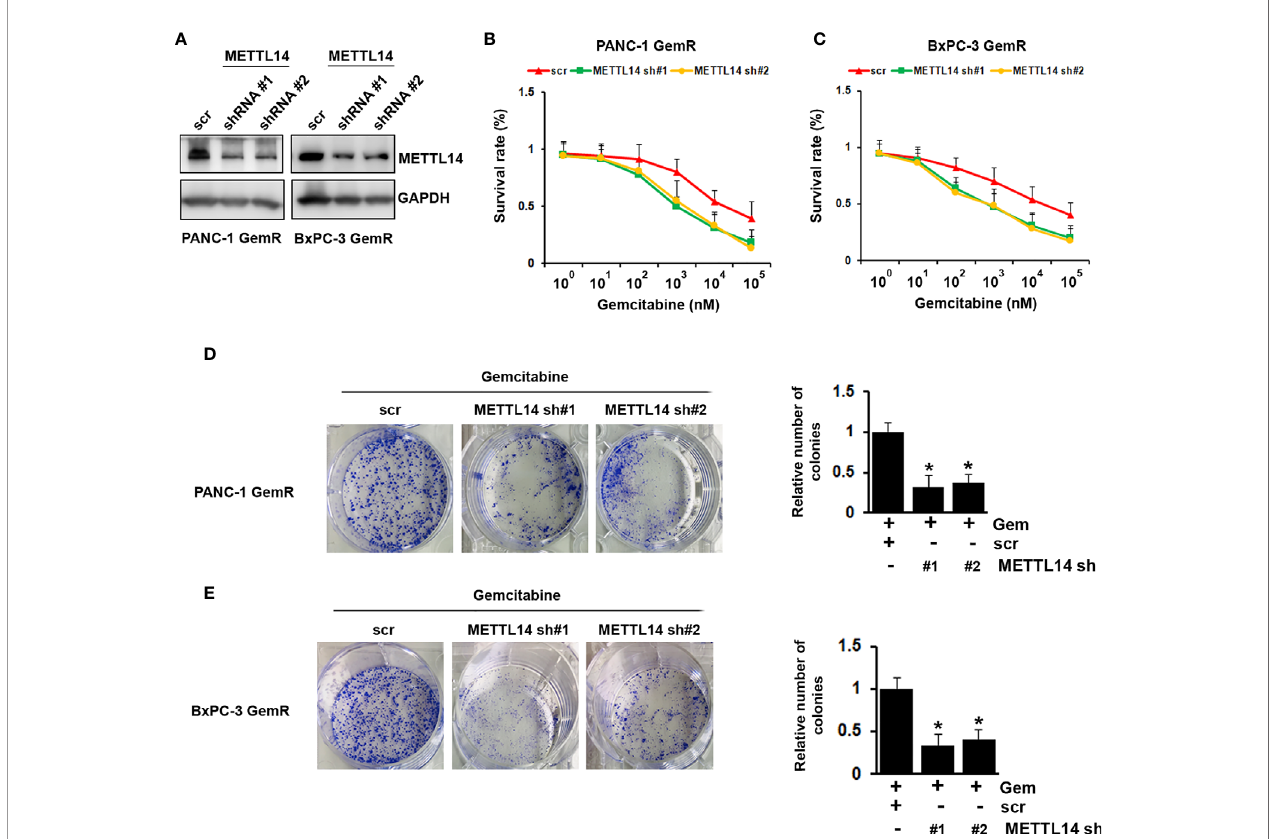
FIGURE 3 | Effect of METTL14 depletion on gemcitabine resistance in pancreatic cancer cells. (A) The protein level of METTL14 was assessed by western blotting in PANC-1 GemR/BxPC-3 GemR cells after infected with METTL14 shRNA. (B, C) Gemcitabine IC50 experiment was performed in PANC-1 GemR/BxPC-3 GemR cells after infected with METTL14 shRNA. (D, E) PANC-1 GemR (D) and BxPC-3 GemR (E) cells were performed colony formation assay after infected with METTL14 shRNA followed with gemcitabine treatment. *p value <